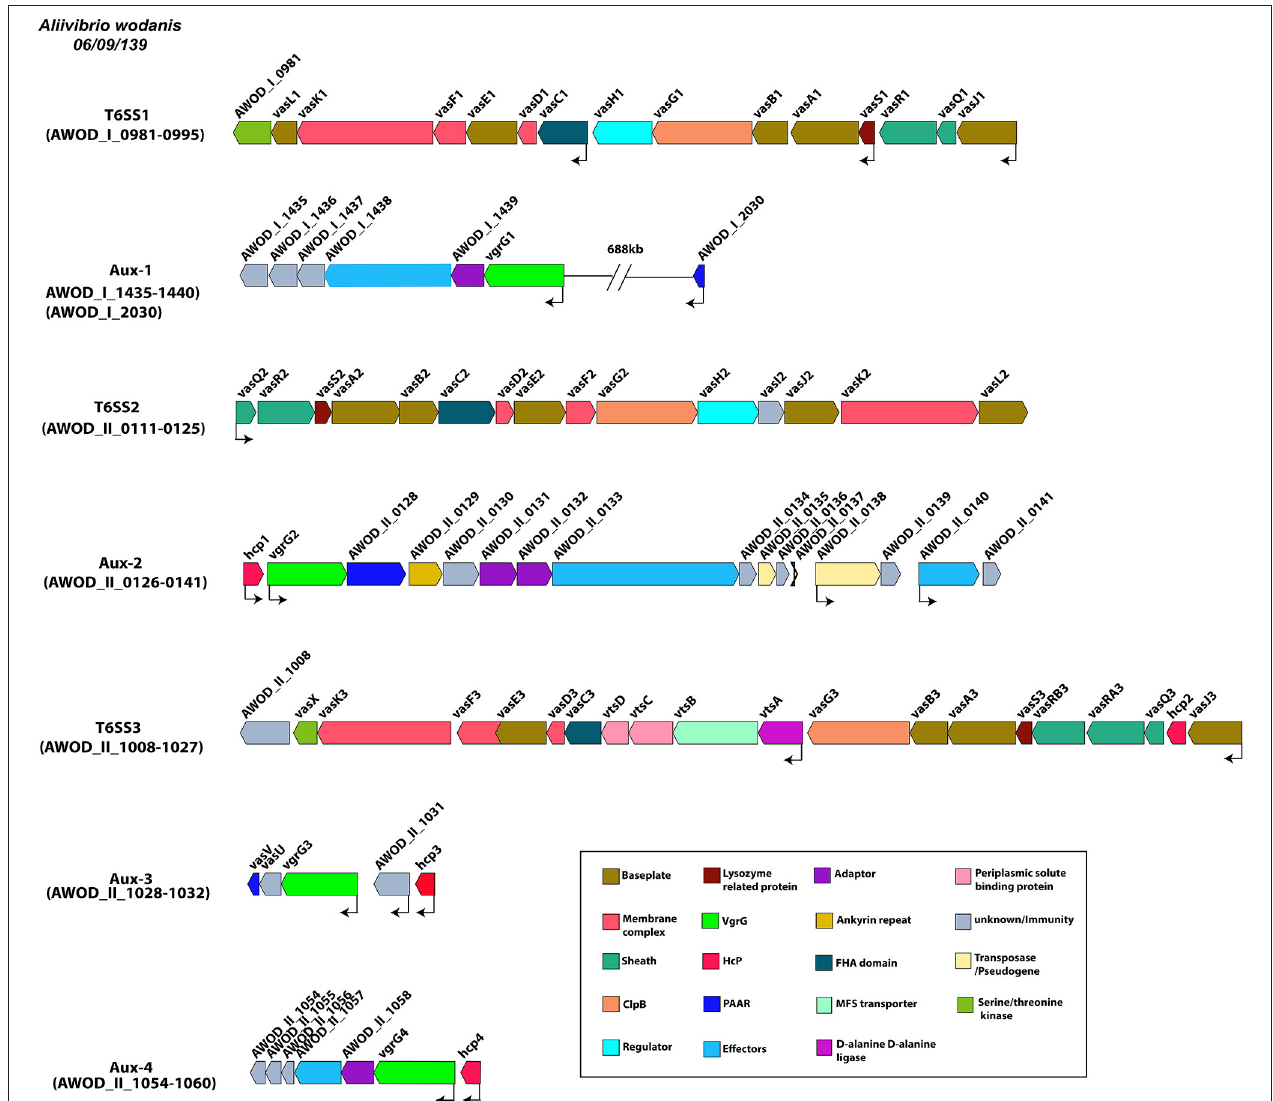
FIGURE 3 | Type VI secretion systems in A. wodanis 06/09/139. Graphical representation of the three main T6SSs of A. wodanis and the four auxiliary T6SS clusters. The thin black arrows indicate the direction and start of the transcription